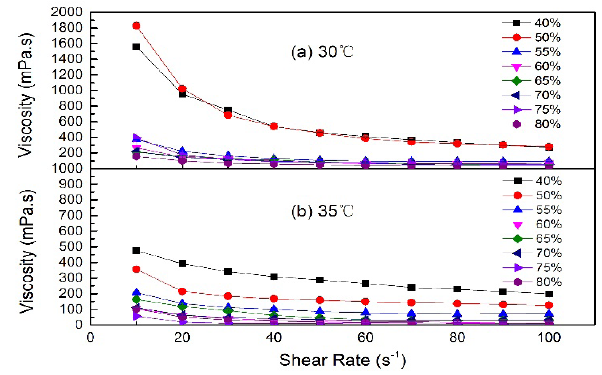
Figure 5: The influence of polymer concentration (1053mg/L ) on rheological behaviors at the temperatures (a) 30